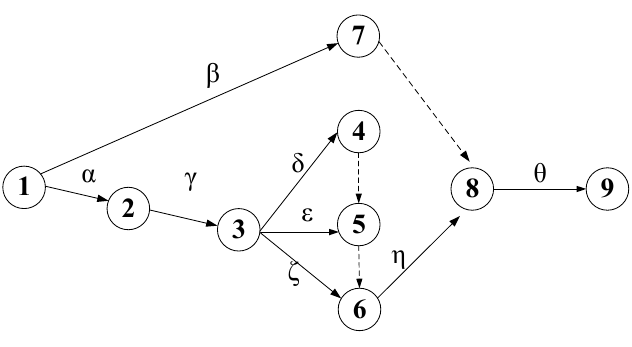
Figure 2. Network for the wind turbine project. Table 2. Activities for wind turbine project.